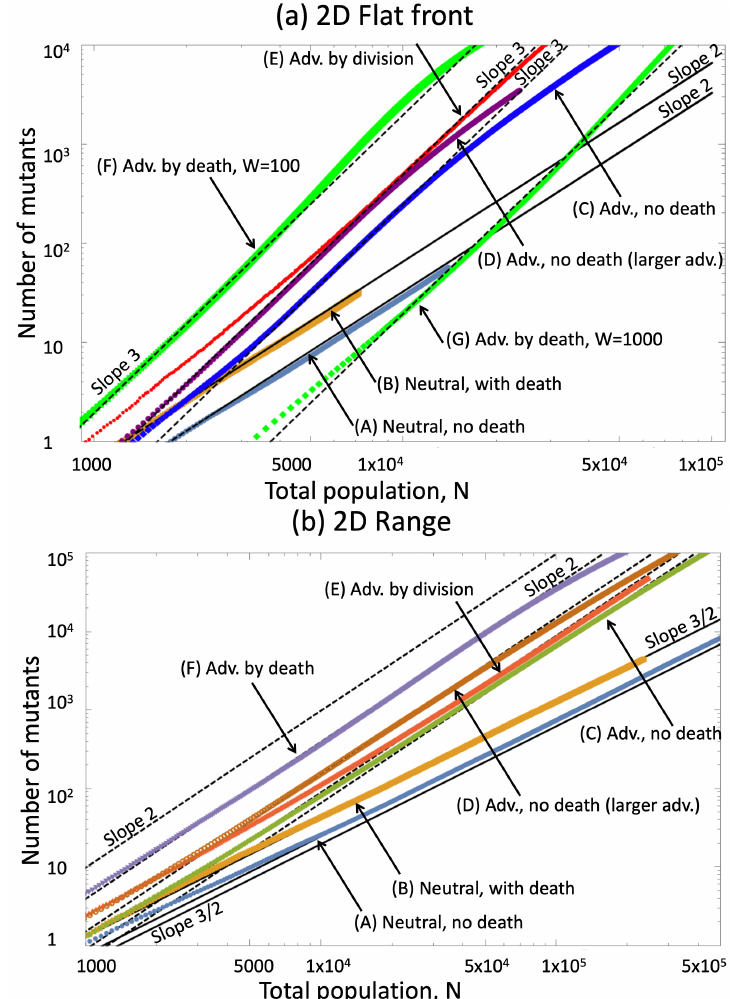
Figure 6. Neutral and advantageous mutants in a 2D colony under ( a ) a flat front expansion and ( b ) a range expansion. The number of mutants is plotted as a function of the total population, averaged over 1000 stochastic runs (standard error is too small to see). Cases (A,B) are neutral, and the corresponding solid black lines are guides to the eye, with ( a ) slope 2 and ( b ) slope 3/2 in the log–log plot. Cases (C–G) are advantageous, and the dashed lines are guides to the eye with ( a) slope 3 and ( b ) slope 2. Curves (A–G) are described in Table 3. The rest of the parameters are u = 5 × 10 − 5 , W = 100 (except G, where W =